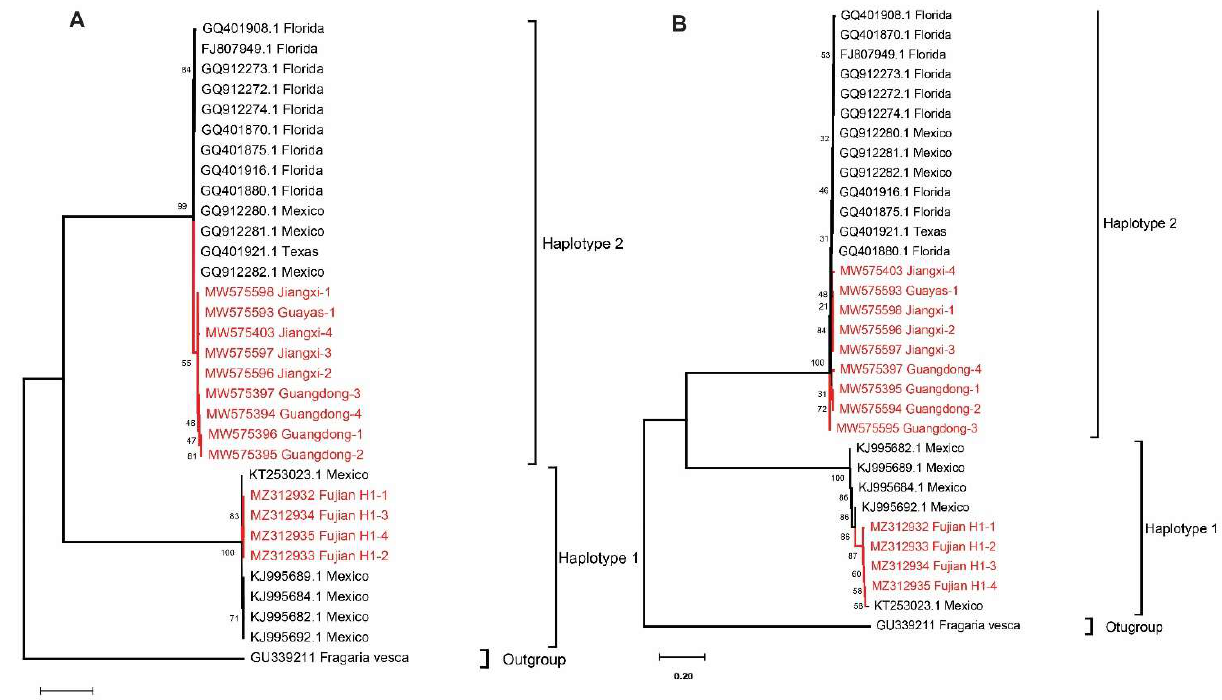
Figure 3. Phylogenetic analysis based upon an alignment of COI sequences of 13 different populations of Tamarixia radiata . ( A ) Phylogenetic tree based on the Maximum Likelihood method through the General Time-Reversible model under the initial tree option of maximum parsimony, while ( B ) shows a phylogenetic tree constructed through the Neighbor-Joining method by the Maximum Composite Likelihood model. All COI sequences of Tamarixia radiata obtained in the study are highlighted in red lines and font.